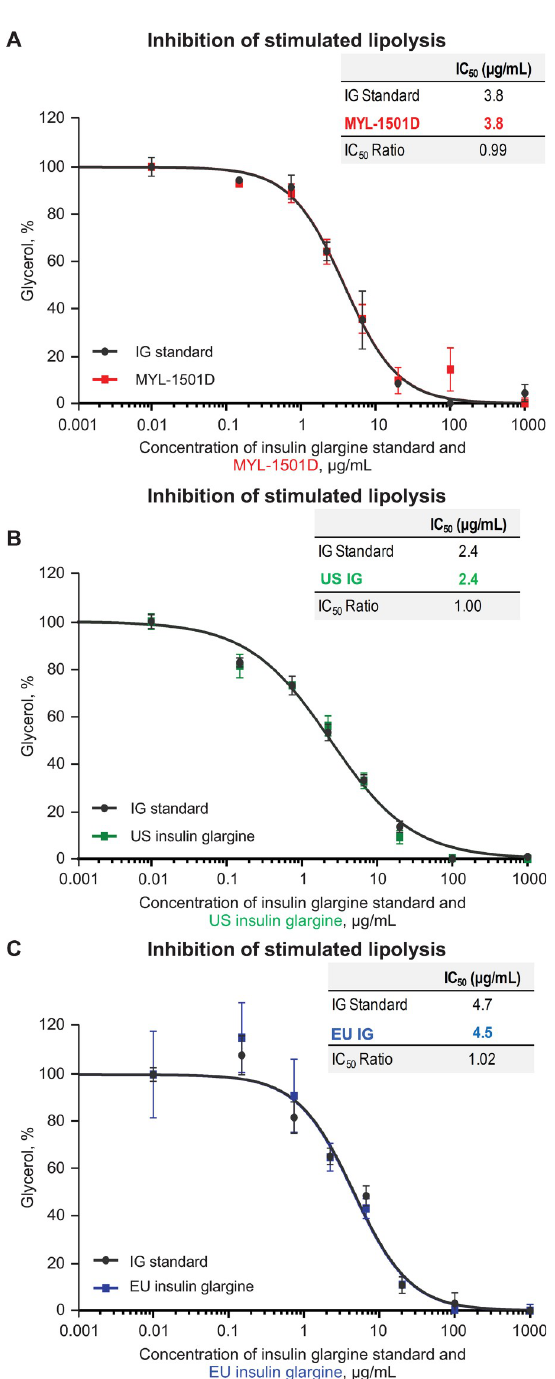
Fig 15. Representative dose-response curves graph of inhibition of stimulated lipolysis assay in 3T3-L1 cells. (A) MYL-1501D, (B) US-Licensed Insulin Glargine, and (C) EU-Licensed Insulin Glargine. All samples were analyzed against a common insulin glargine reference standard (IG standard) to normalize against day-to-day variability. Each lot was analyzed using 3 independent dilution preparations on an assay plate. Mean ± SEM for the % glycerol measured is plotted (y-axis) against the concentration (x-axis). Four parameter logistic curve fit was applied to evaluate EC 50 . Each sample was analyzed on 3 independent assay plates, and average is reported. EC 50 , half maximal effective concentration.